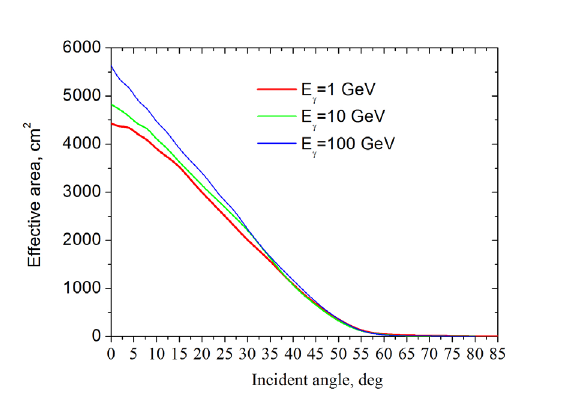
Figure 6. The dependence of the angular resolution vs the energy for: GAMMA-400 (80 µ m pitch, analog readout) and Fermi-LAT (228 µ m pitch, digital